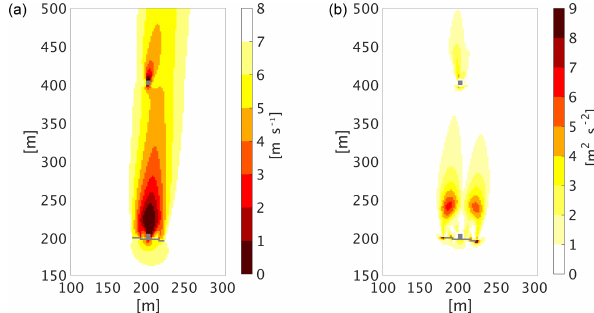
Figure 8. Horizontal cross section of the domain at 38m of height showing (a) the wind speed and (b) the turbulent kinetic energy (right) in the vicinity of a wind turbine (Nibe B) and the tower of another wind turbine (Nibe A, out of service in the simulation). A mean wind flow of 8.5ms − 1 in the south direction was simulated in a neutrally stratified flow. The roughness length is set to 0.014m and the Coriolis force is considered in the